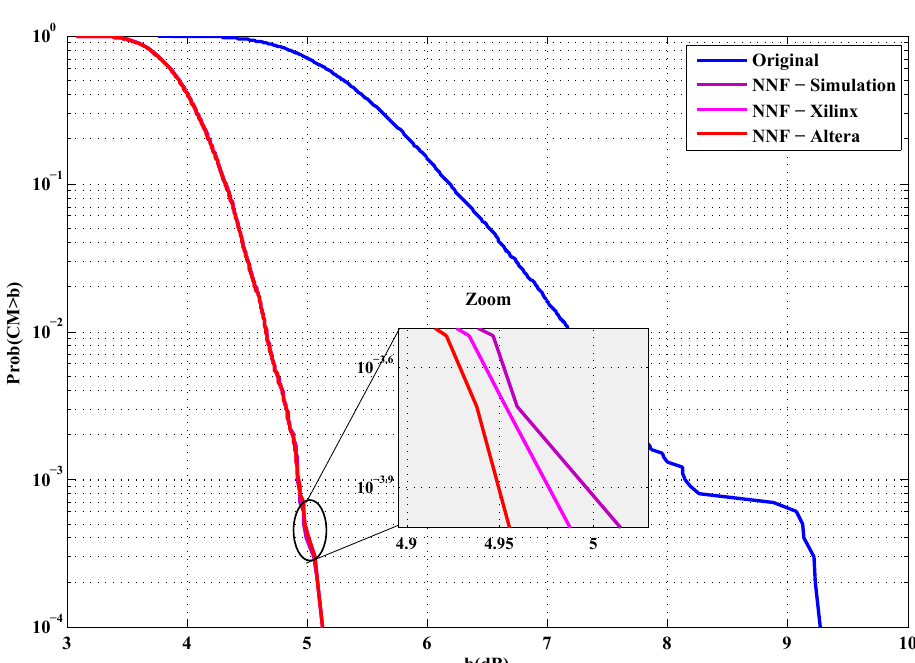
Figure 17. ECMA-368 cubic metric reduction in the case of DCM